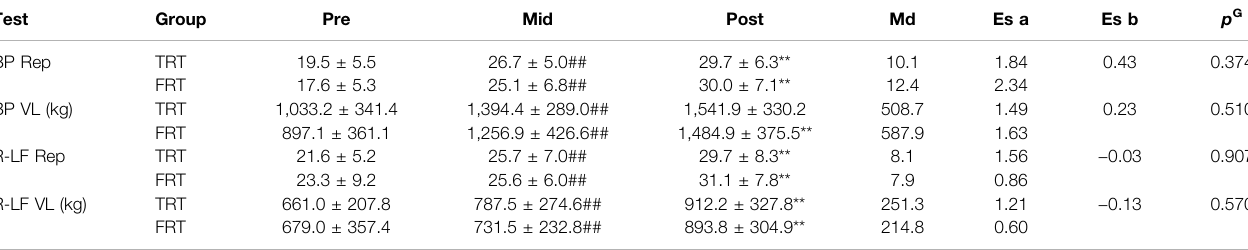
TABLE 3 | Change in upper and lower limbs muscular endurance as mean difference, a statistical test of group difference and effect sizes as Cohen d. Test Group